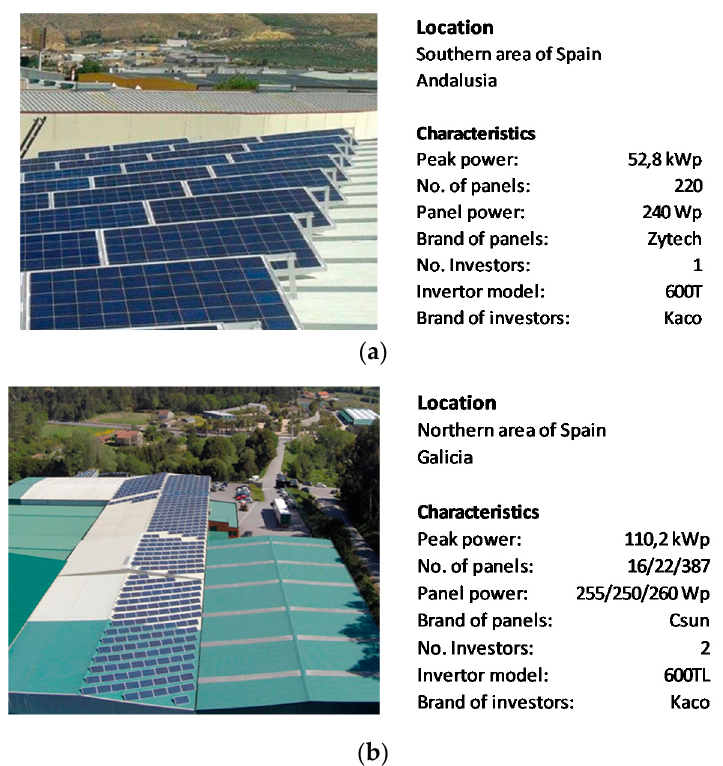
Figure 1. ( a ) Data of the photovoltaic self-consumption generation installation, industry A; ( b ) Data of the photovoltaic self-consumption generation installation, industry B.